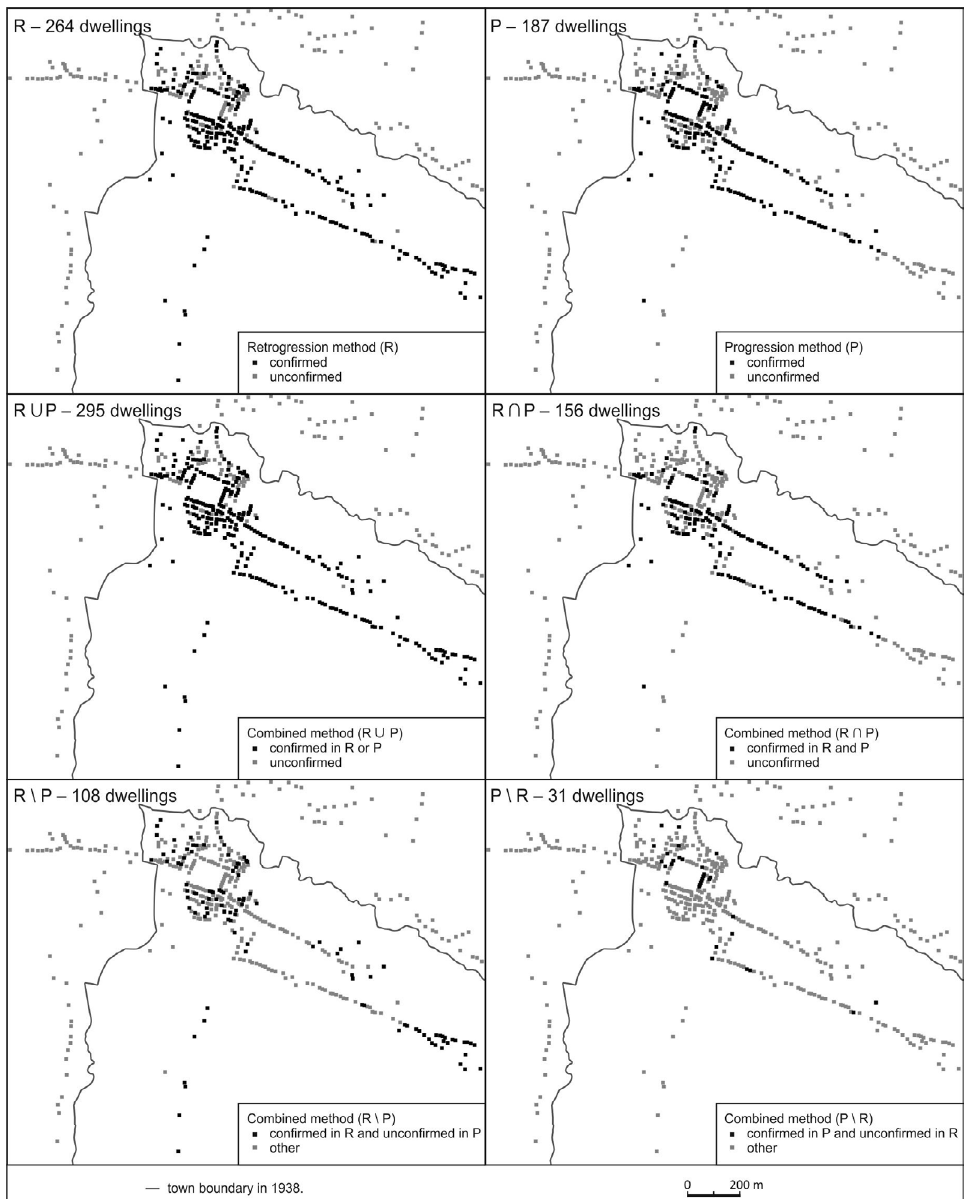
Fig. 5. Dwelling houses in 1938. The comparison of results achieved with retrogression, progression and combined methods (J. Kuna